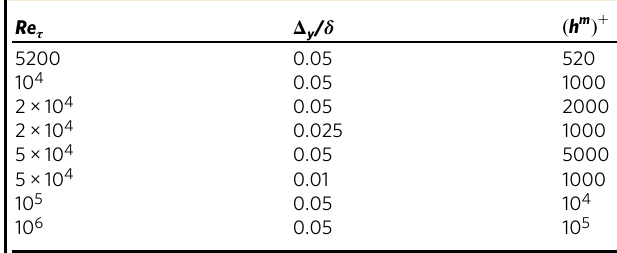
For all cases, Δ x,z / δ =